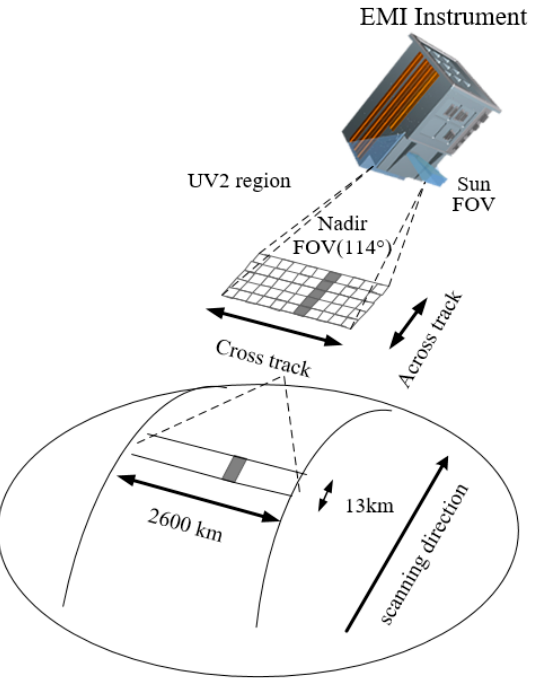
Figure 1. Environmental trace gases Monitoring Instrument (EMI) nadir scanning map.